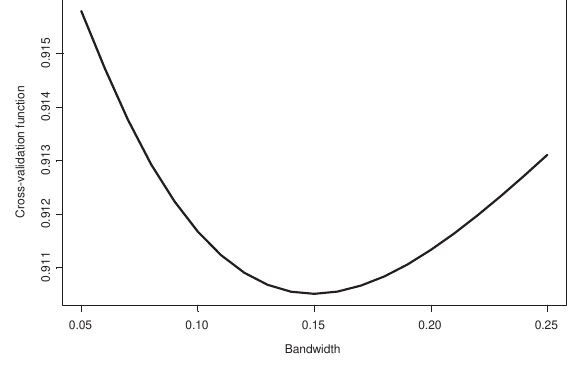
Fig. 1. Cross-validation function for the NFE